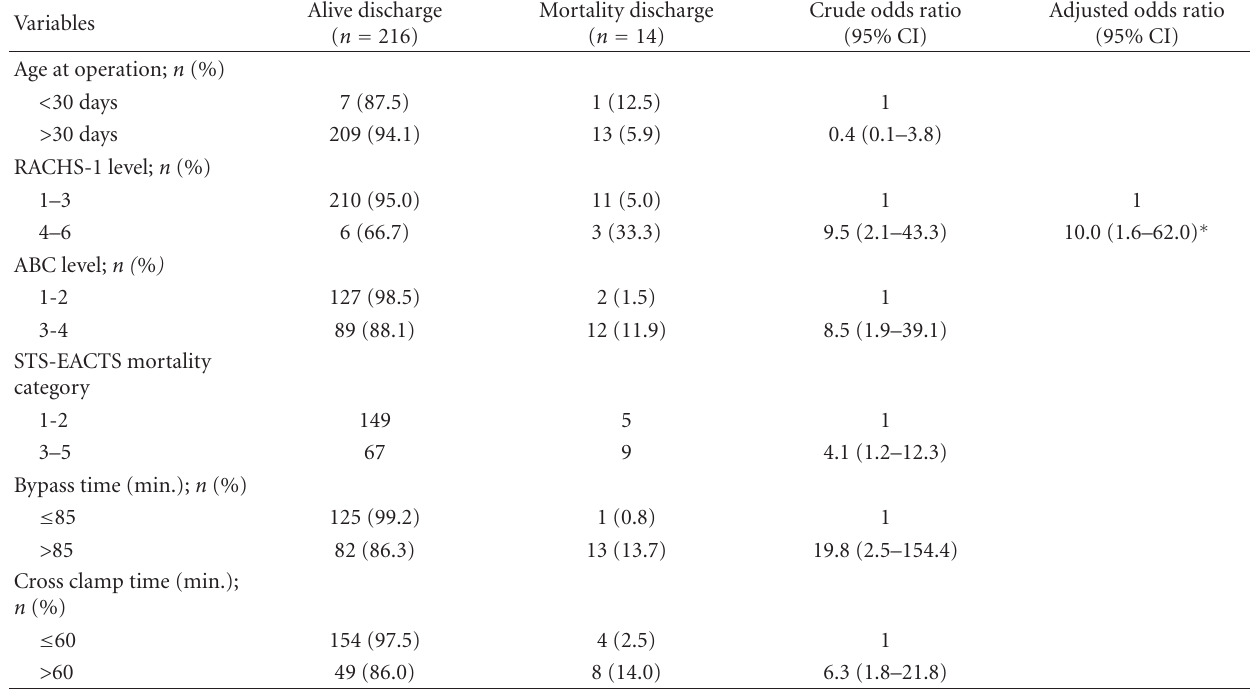
Table 6: Risk of death estimated by univariate and multivariate analysis using categorical data in the present